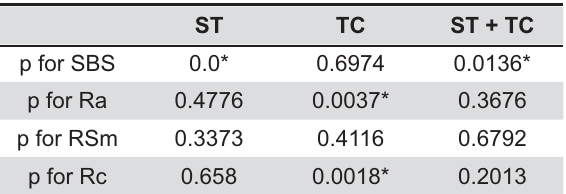
Table 1- The p value by 2-way ANOVA determined for shear bond strength (SBS) and roughness parameters (Ra, RSm and Rc) for different factors (surface treatment, ST; Thermocycling, TC) (* p (cid:2)(cid:3)(cid:4)(cid:3)(cid:5)(cid:6)